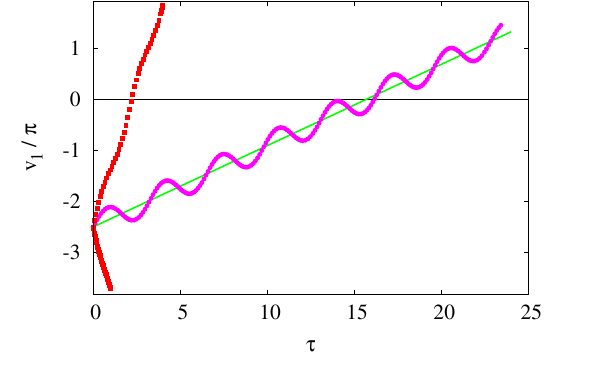
ð (cid:12) Þ versus (cid:12) for a ¼ 1 = 2 , k ¼ 0 , A ¼ 2 as in Fig. FIG. 3. v 1